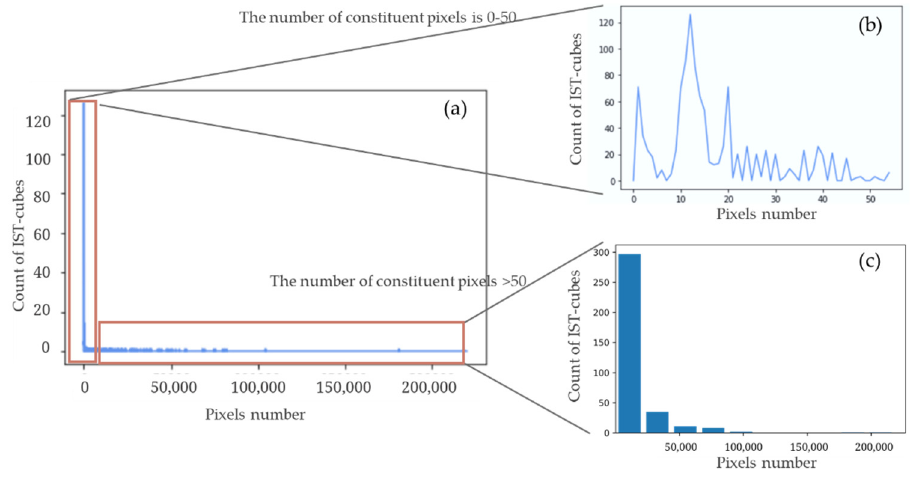
Figure 7. IST-cube containing the number of pixels distribution. ( a ) General sketch of the IST-cube containing the number of pixels distribution. ( b ) Line chart of the distribution of the IST-cube, whose constituent pixels are less than 50. ( c ) Box plot of the IST-cube distribution, where the constituent pixels are more than